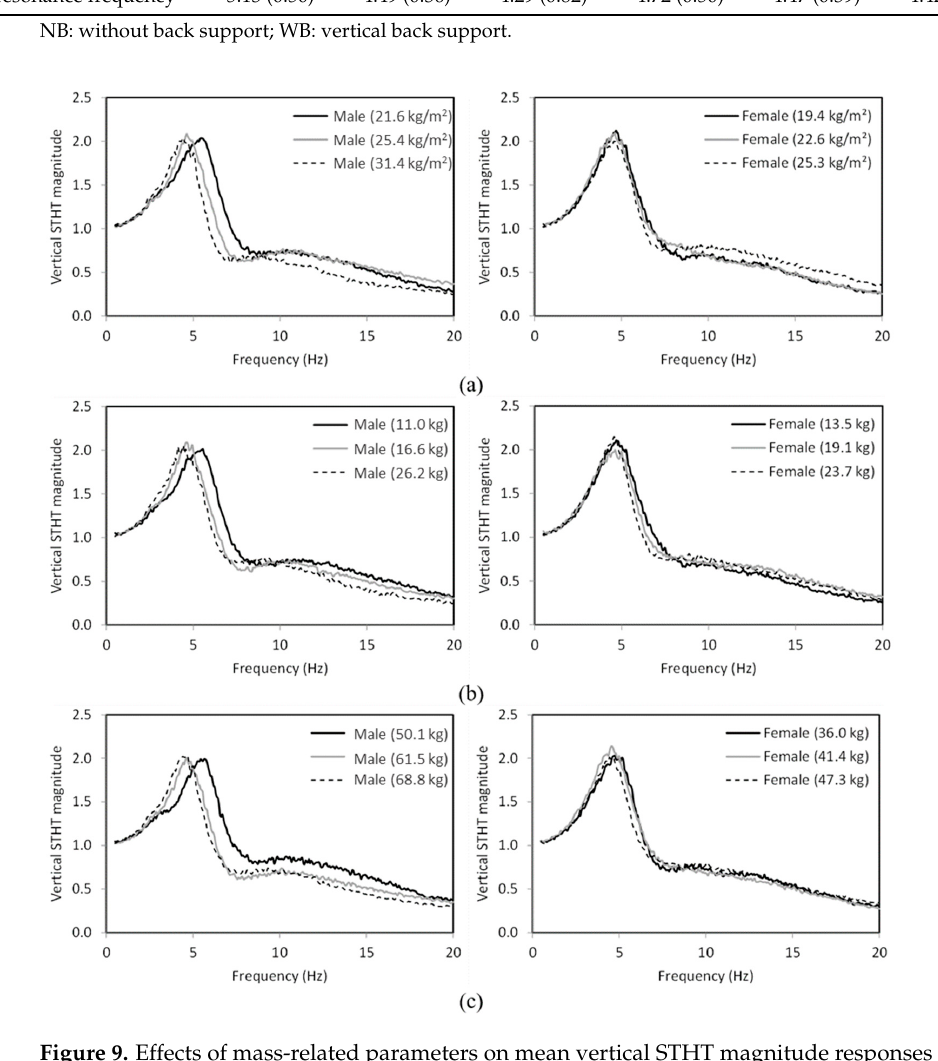
Figure 9. Effects of mass-related parameters on mean vertical STHT magnitude responses of males and females: ( a ) BMI; ( b ) body fat mass; and ( c ) lean body mass (NB support, 0.50 m/s 2